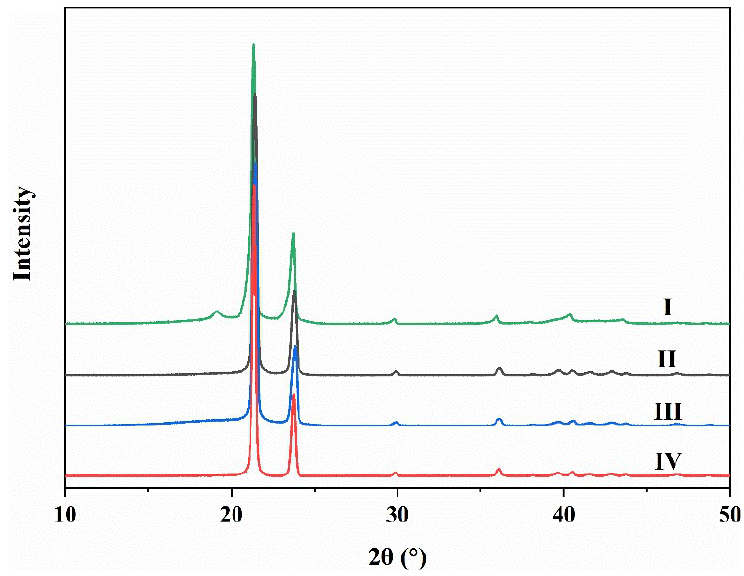
Figure 8. X-ray diffraction spectra of BW (I), PEW (II), PEW- g -MAH (III), and PEW- g -MAH-MMA